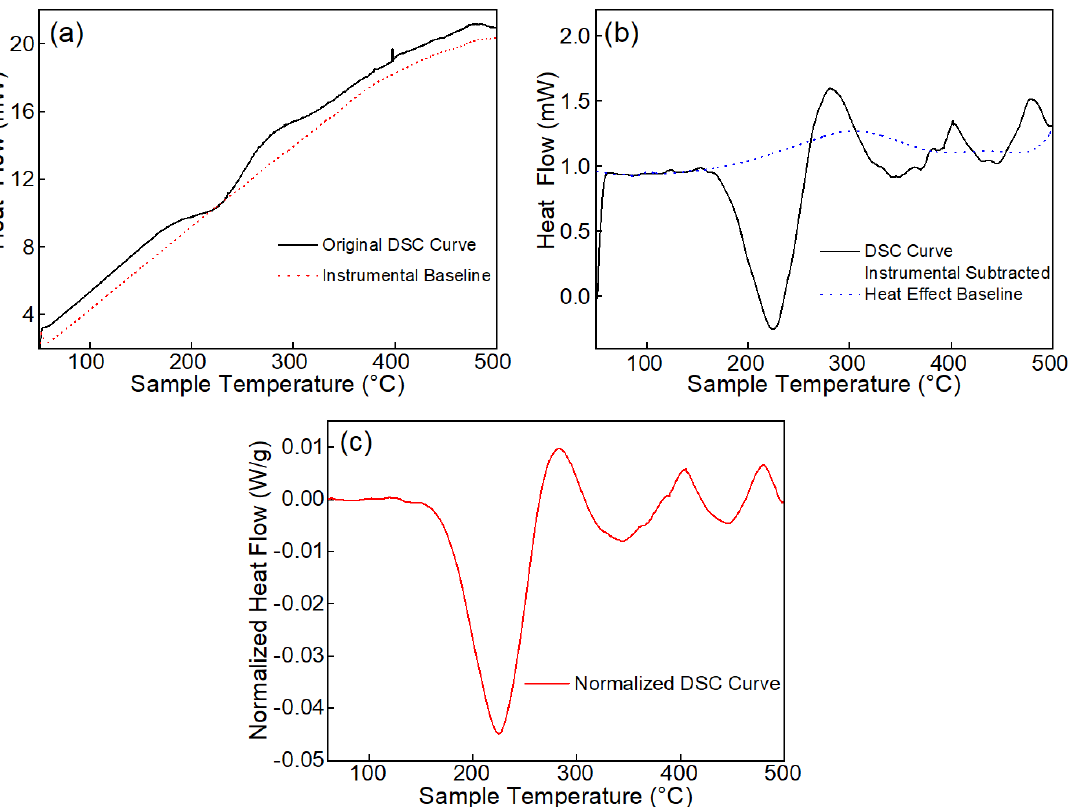
Figure 1. Correction process of the DSC curves: ( a ) subtraction of instrumental baseline; ( b ) subtraction of heat-effect baseline; and ( c ) normalization according to the mass of the sample.